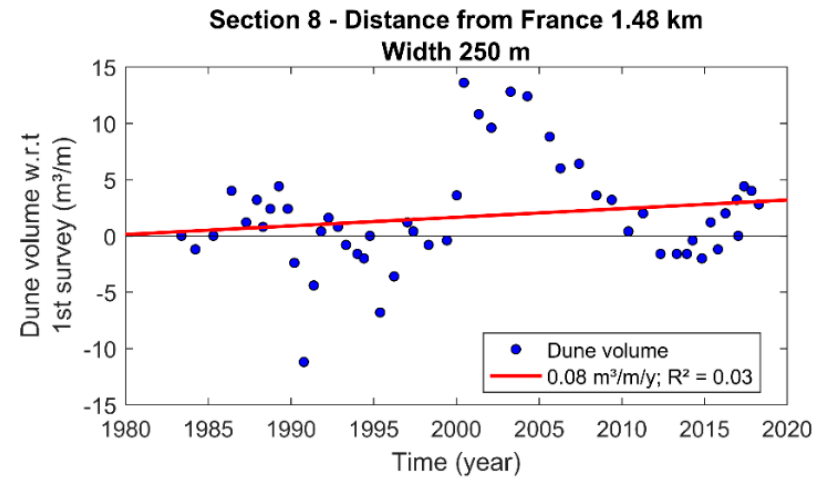
Figure 12. Decadal dune evolution of the coastal dunes at section 8.